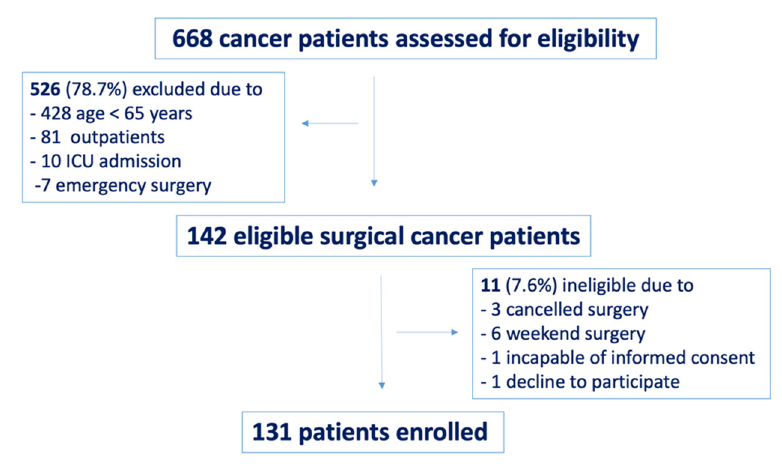
Figure 1. Study flow chart. Table 1. Preoperative variables in elderly cancer patients according to Mini-Cog score.